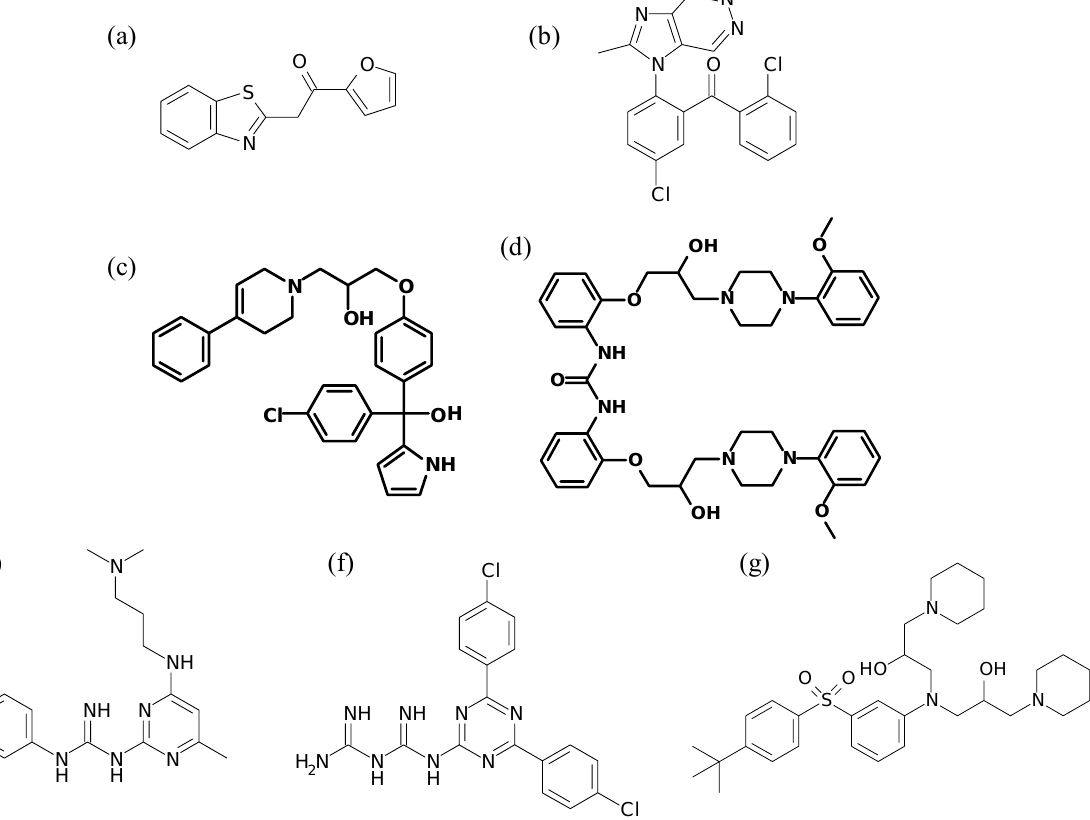
Figure 2. Haemozoin inhibitors identified through HTS [50]. The compound classes (a) miscellaneous, (b) benzophenone, (c) triarylcarbinol and (d) piperazine were identified experimentally, while compounds (c) – (g) were identified using in silico methods. The structures in bold [(c) and (d)] represent the intersection of these two